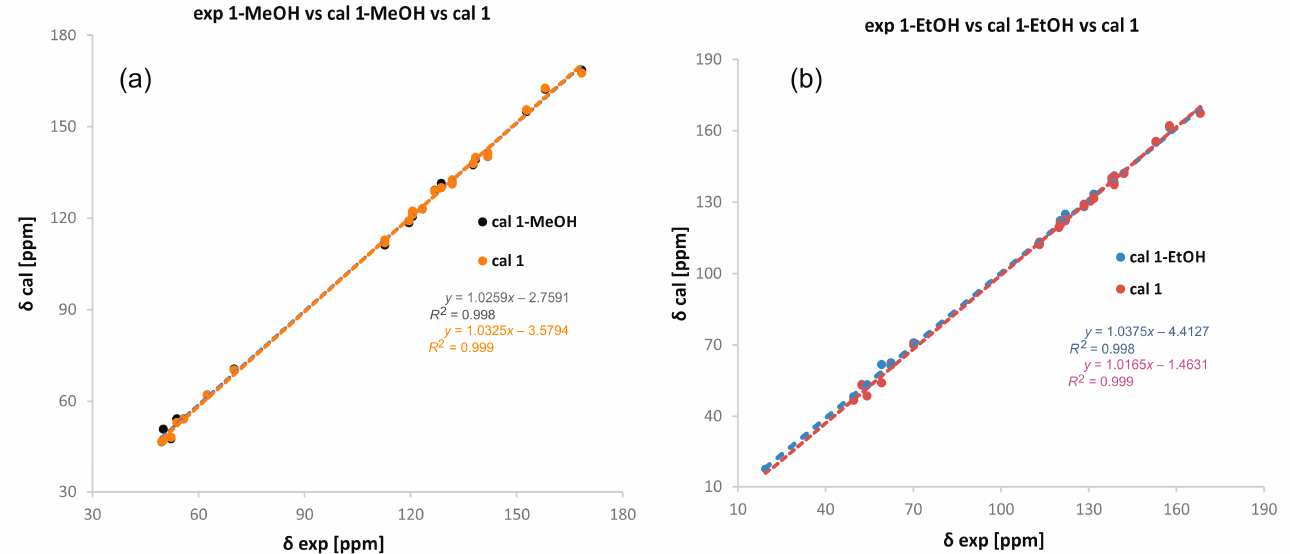
Figure 4. Correlation between experimental and theoretical chemical shifts of carbon-13 in 1-MeOH ( a ) and 1-EtOH ( b ). Theoretical δ values have been calculated in CASTEP [26] for structures with optimized all atom positions and the lattice parameters fixed to experimental values. Two sets of structures have been considered: with one solvent per molecule of 1 and without solvent.